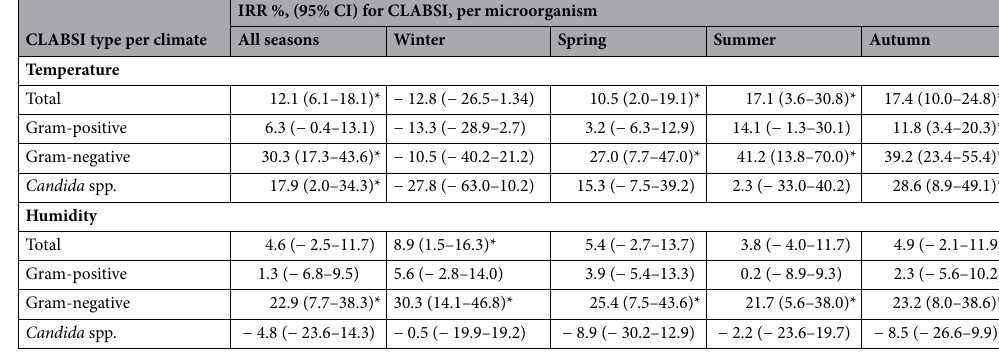
Table 4. Associations between hospital-wide central line-associated bloodstream infections and weather, year- long and by season. Estimates of the mixed-effects negative binomial regression model, adjusted for university- status and infection risk exposure. All season model controls for season; seasonal models assessed weather- by-season interaction term. Adjusted incidence rate ratios (IRR) are expressed as a percentage change with 95% confidence intervals per increase of 5 °C average temperature or 10% relative humidity. CLABSI central line-associated bloodstream infection. *P-value significant (≤